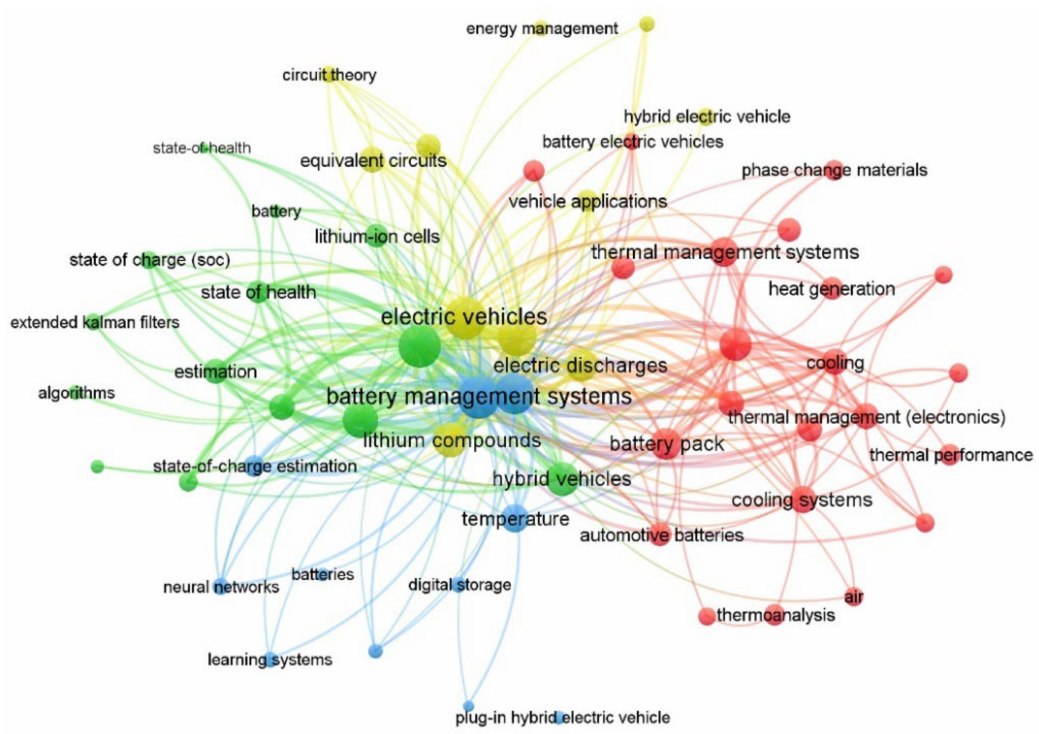
Figure 5. Representation of co-occurrence keywords for analytical analysis of BMS technology for EV